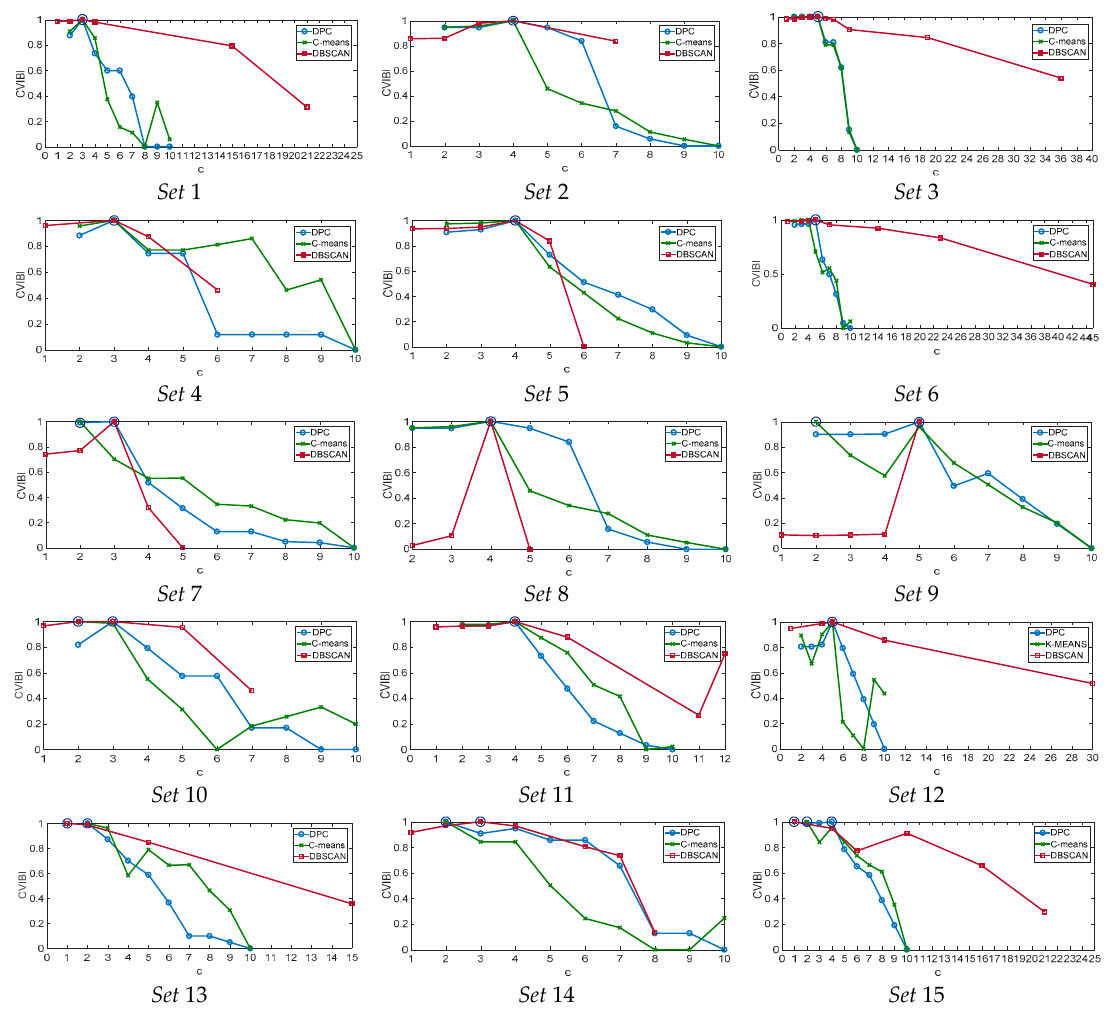
Figure 10. Evaluation results of CVIBI obtained using DPC, C-means, and DBSCAN. Datasets in group 1 and group 2 contain clusters with different densities and sizes, respectively.